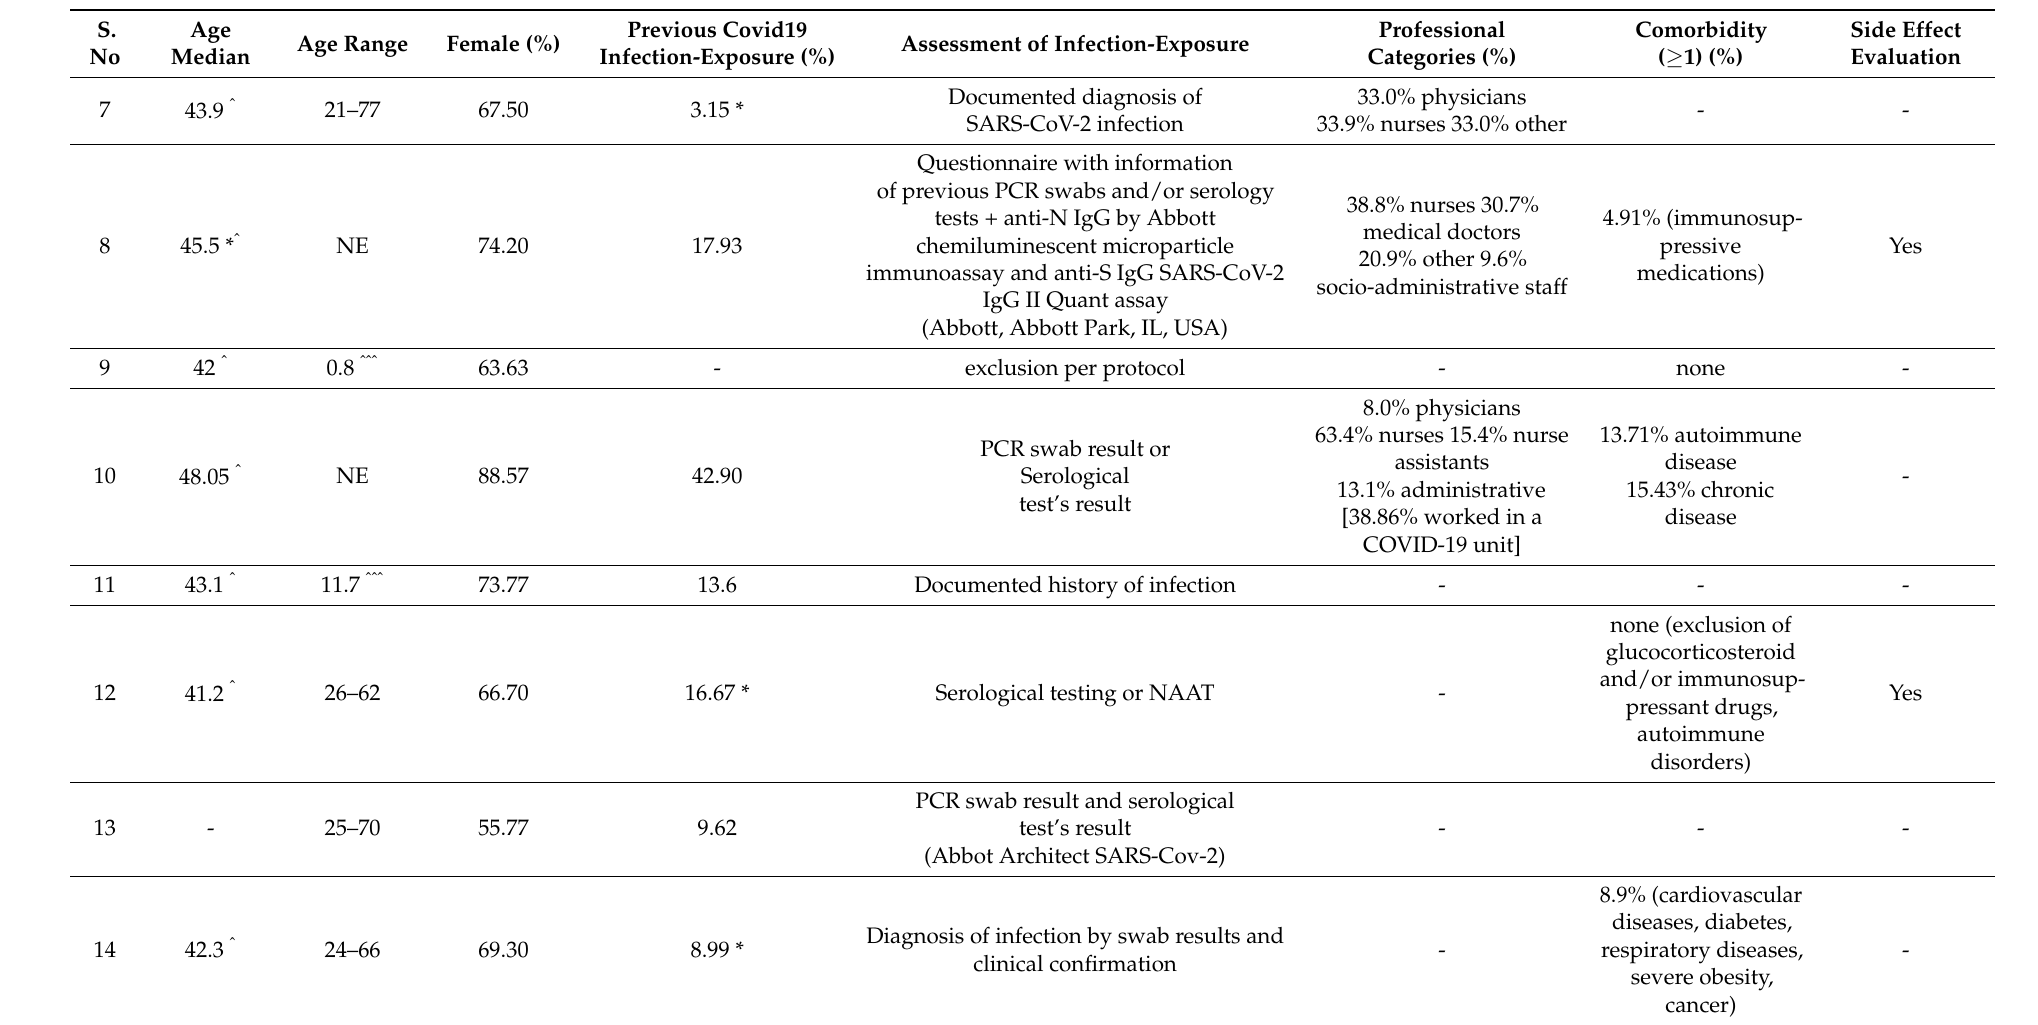
Table 2. HCWs demographic